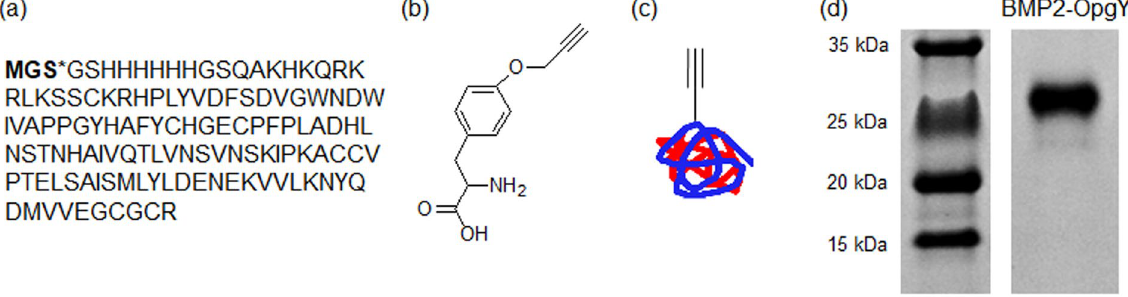
Figure 2. ( a ) Amino acid sequence of BMP2-OpgY, ( b ) chemical structure of O -propargyl-tyrosine (OpgY), ( c ) schematic image of BMP2-OpgY, and ( d ) sodium dodecyl sulfate-polyacrylamide gel electrophoresis of BMP2- OpgY. Sulfate-polyacrylamide gel was cropped and full-length gel included in Supplementary Fig.